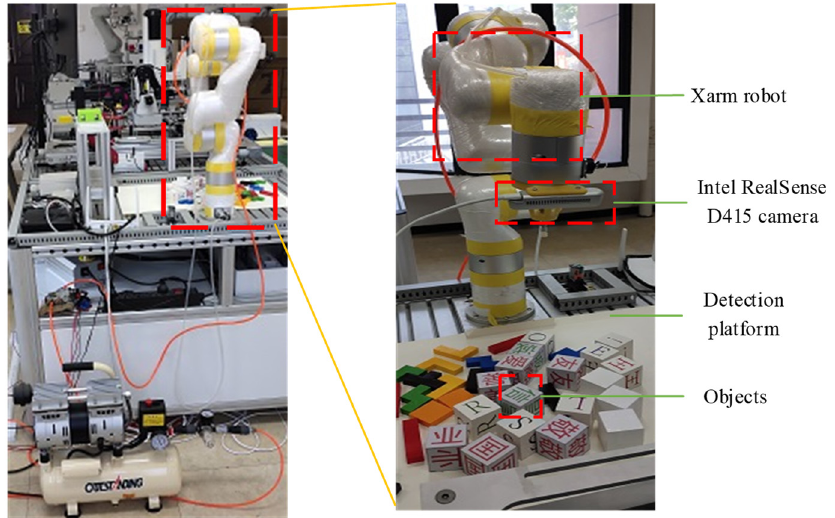
Figure 2. Robot object detection platform .